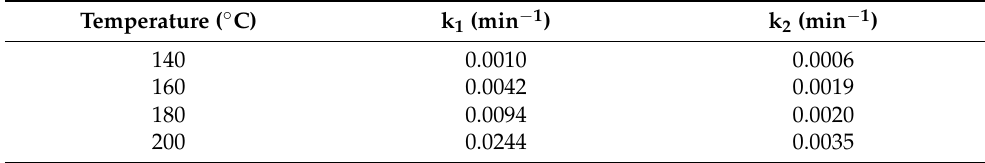
Table 2. Kinetic rate constants at different